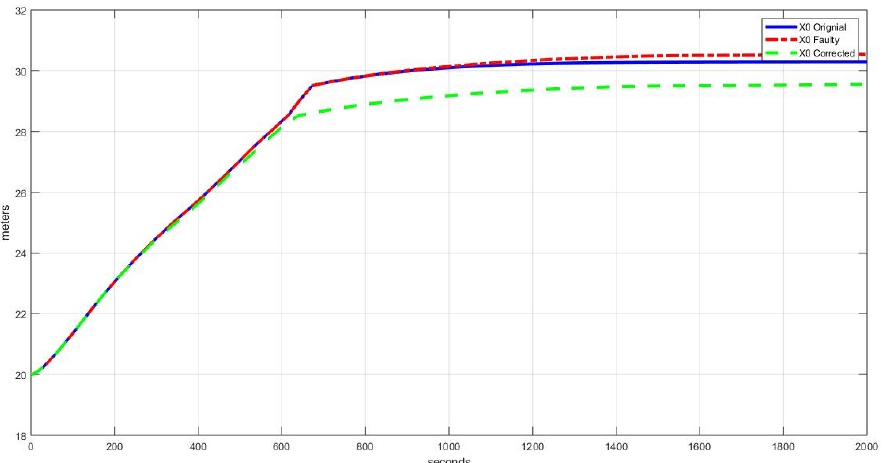
Figure 18. Power with faulty and fault-corrected operation given a sluice gate w 1 leakage fault.